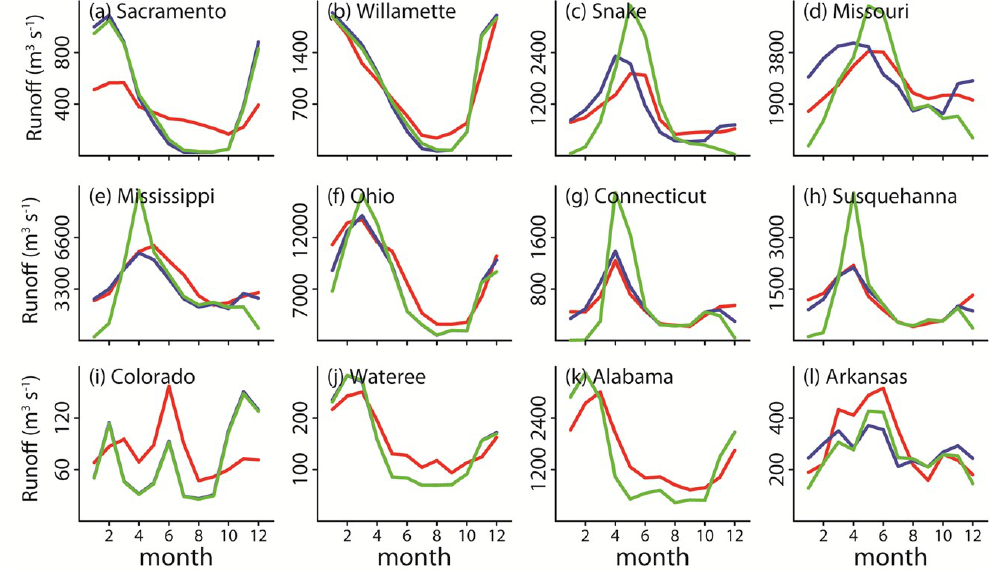
Fig. 12. Monthly river runoff simulated by LH (a) under the addition of solar radiation for snowmelt computation (blue line), and (b) using a degree-day method for snowmelt computation (green line), and (c) USGS observed average monthly runoff (red line) for 12 major rivers in the